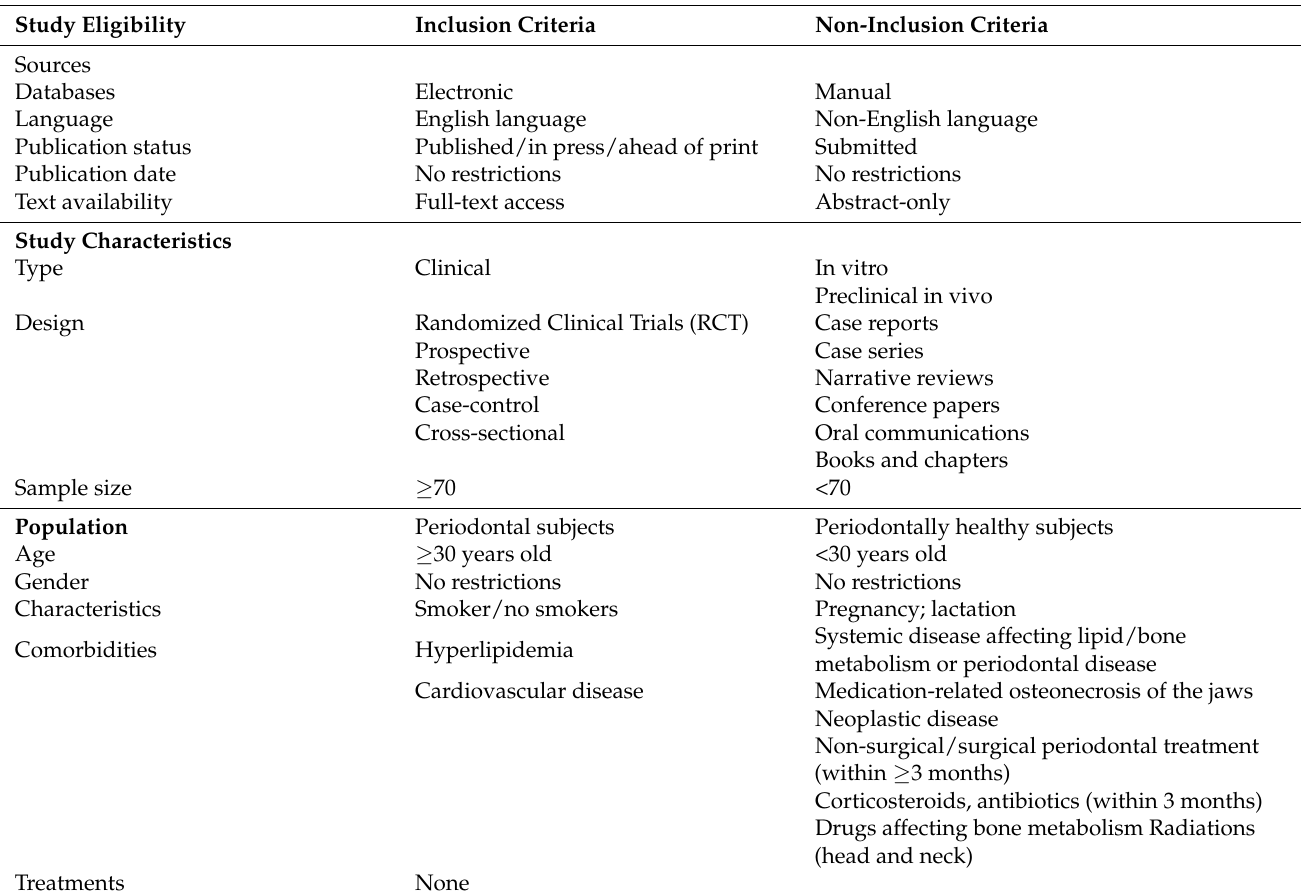
Table 1. Study eligibility: inclusion and non-inclusion criteria related to study sources, characteristics, population, interven- tion, comparison and